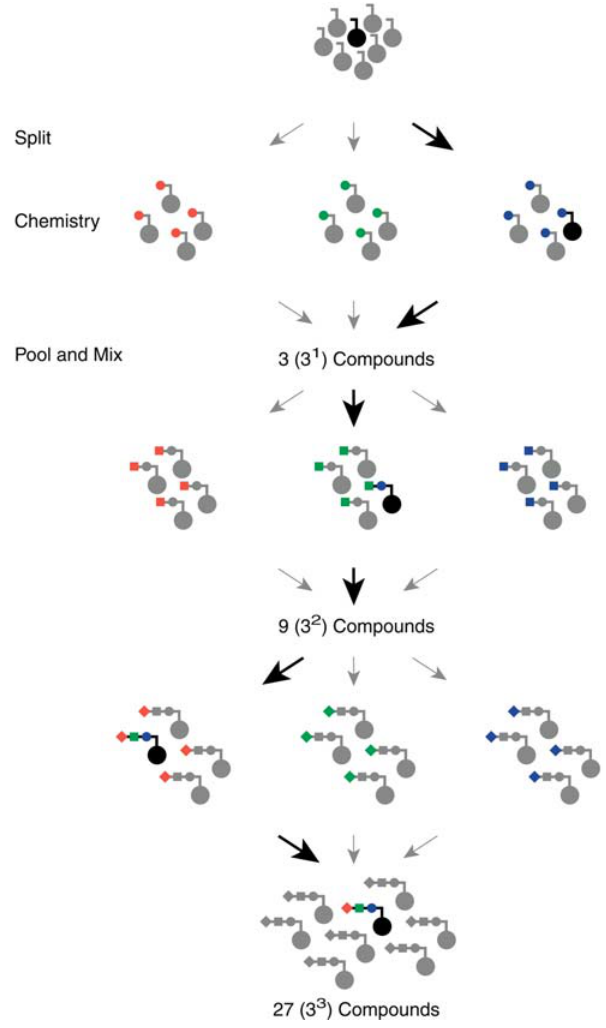
Figure 2. Split-and-Pool Synthesis of a Combinatorial Chemistry Library A mixture of solid supports (balls with rotated ‘‘ L ’’ at top) is randomly split into subpools. A distinct chemical building block (red, green, or blue ball) is coupled to the supports in each subpool. The supports are repooled and mixed. This process of splitting, chemistry, and pooling is iterated until the library synthesis is complete. The small molecules ultimately synthesized are combinations of the different building blocks (colored circles, squares, and diamonds). As high- lighted by the black bead, the path taken by a support through the split-and-pool synthesis (right, middle, left) determines the small molecule synthesized on it (blue ball, green square, red diamond). The number of reactions performed is the sum of the number of subpools in each split (3 þ 3 þ 3 = 9). The number of unique small molecules generated is the product of the number of subpools in each split (3 3 3 3 3 = 27). DOI: